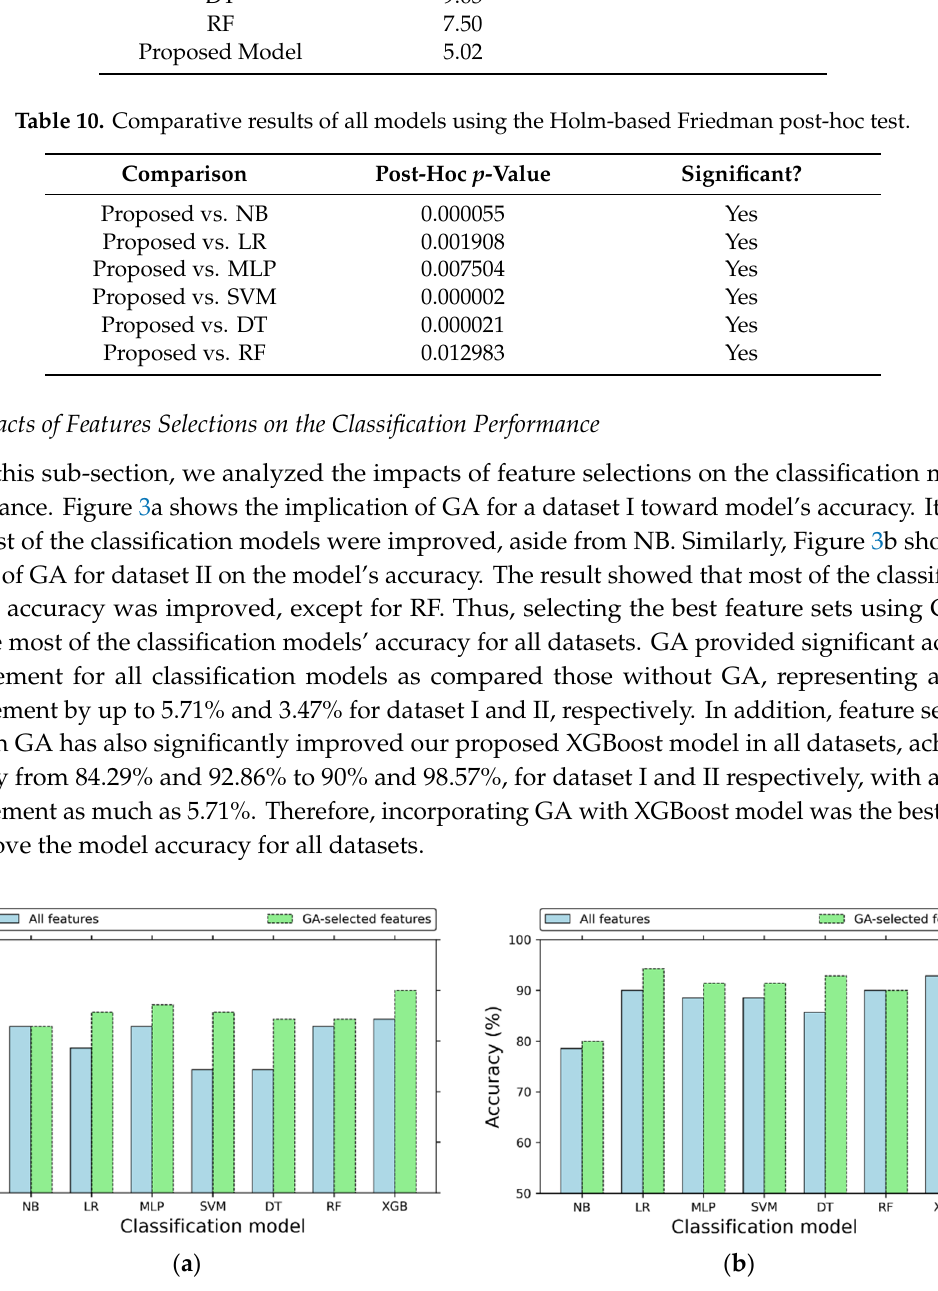
Figure 3. Impacts of genetic algorithms (GA)-based feature selection on the XGBoost model accuracy for dataset ( a ) I (multi-class), and ( b ) II (binary-class).